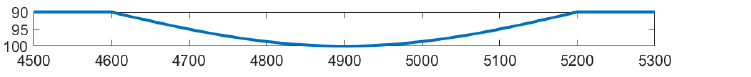
Figure 2. The bottom relief profile of the waveguide (the case of a bottom depression). Figure 3a was obtained for the second incident mode. The solid lines represent the excitation of different modes in the reflected field, and the dashed line represents the reflection coefficient computed under the adiabatic assumption (that is, neglecting the mode coupling).